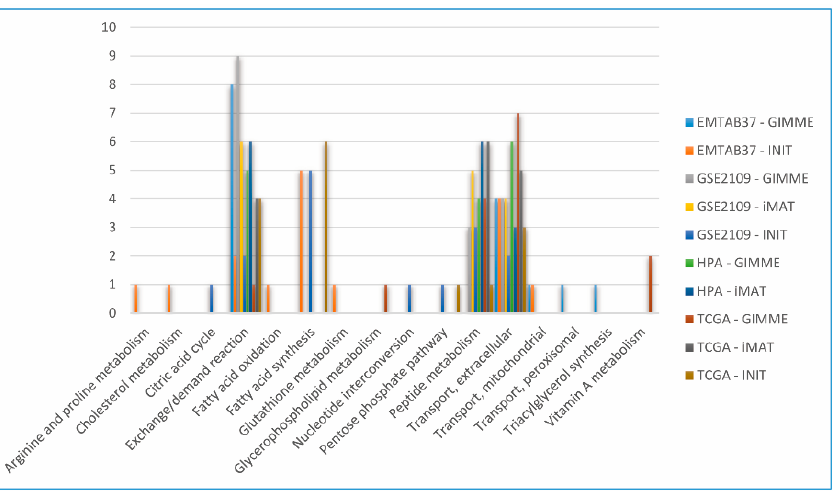
Figure 8. The frequencies of subsystems of important features (reactions) which were selected in the random forest analysis by different dataset–algorithm CGEMs.